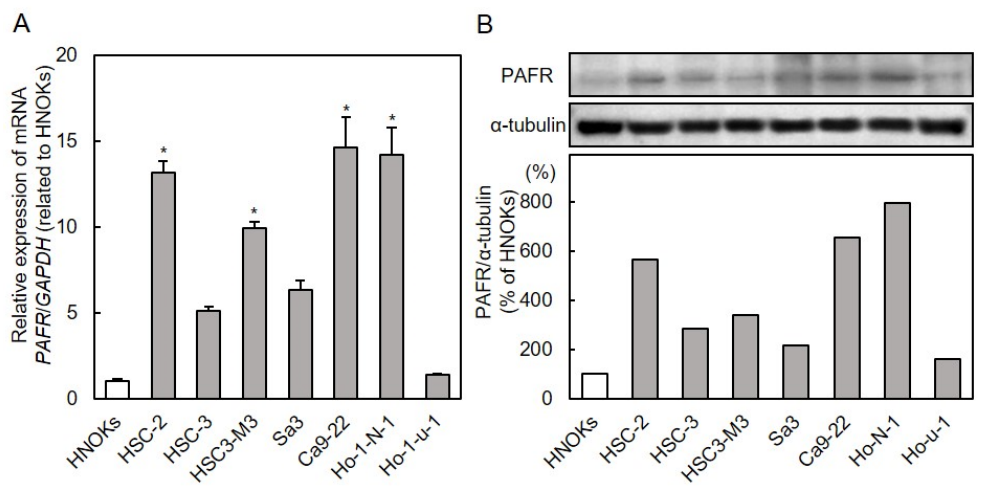
Figure 1. PAFR expression in OSCC cells. ( A ) Quantification of PAFR mRNA expression in OSCC cells by qRT-PCR analysis. PAFR mRNA expression was significantly upregulated in four OSCC cell lines compared to HNOKs (ANOVA with Tukey’s multiple comparison test; *, p < 0.05). ( B ) Representative immunoblot analyses of PAFR protein expression. PAFR protein expression was upregulated in six OSCC cell lines compared to HNOKs. Densitometry data were normalized to α -tubulin protein levels. Values are expressed as percentages of HNOKs. Detailed information about the Western blotting can be found at Figure S1 and Table S1. OSCC, oral squamous cell carcinoma; HNOKs, human normal oral keratinocytes.